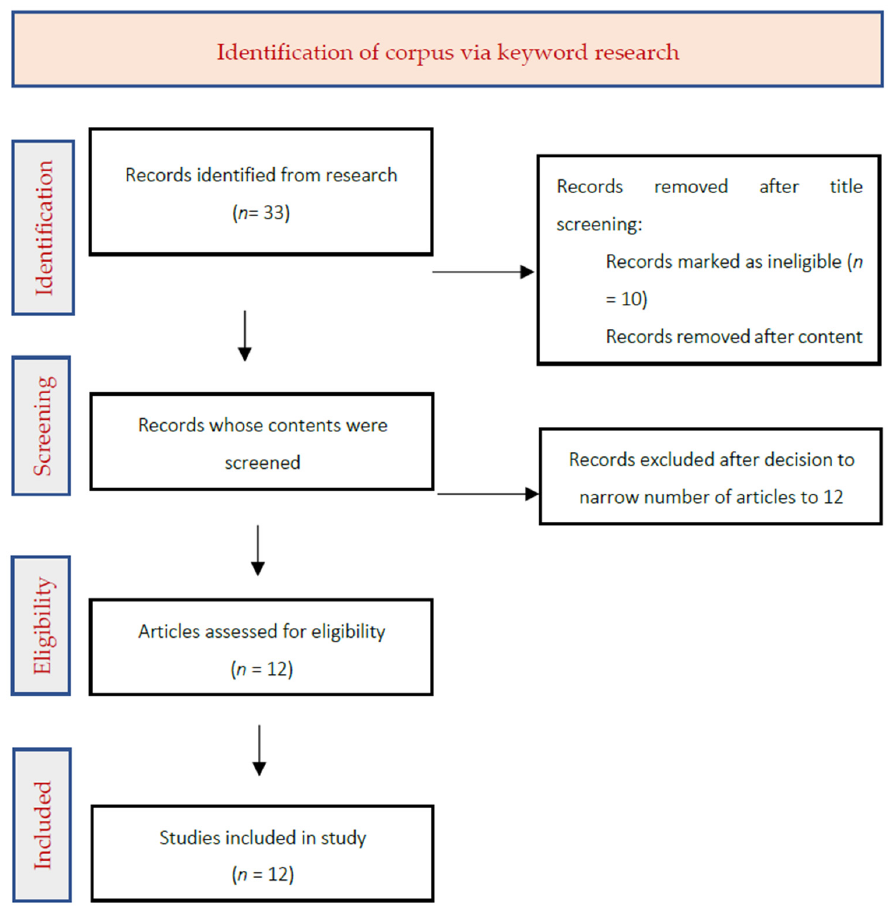
Figure 1. Flowchart of research and eligibility process.